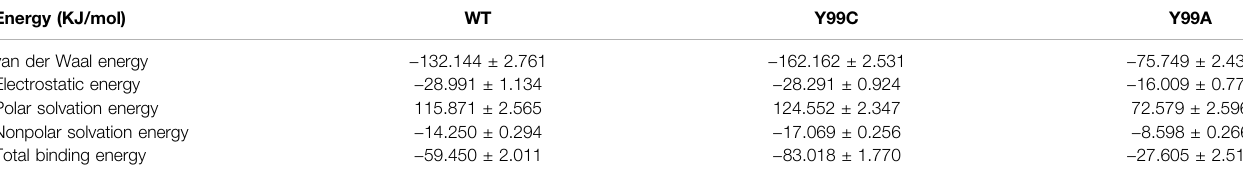
TABLE 3 | Comparison between the binding free energies of RIV in the wild type (WT), Y99C, and Y99A mutants of coagulation factor X. Energy